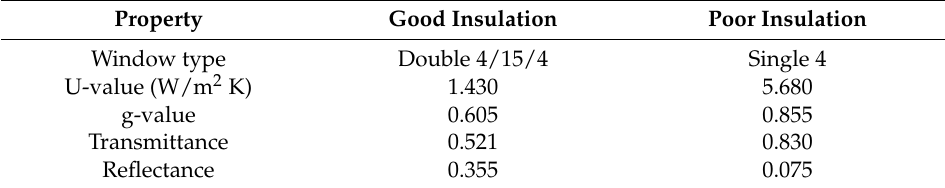
Table 4. Studied cities for each European climate zone defined by Tsikaloudaki et al. [33] (HDD, Heating Degree Days; CDD, Cooling Degree Days; values calculated with Meteonorm data [36]). Table 3. Thermal properties of windows for “Good insulation” and “Poor insulation” buildings.